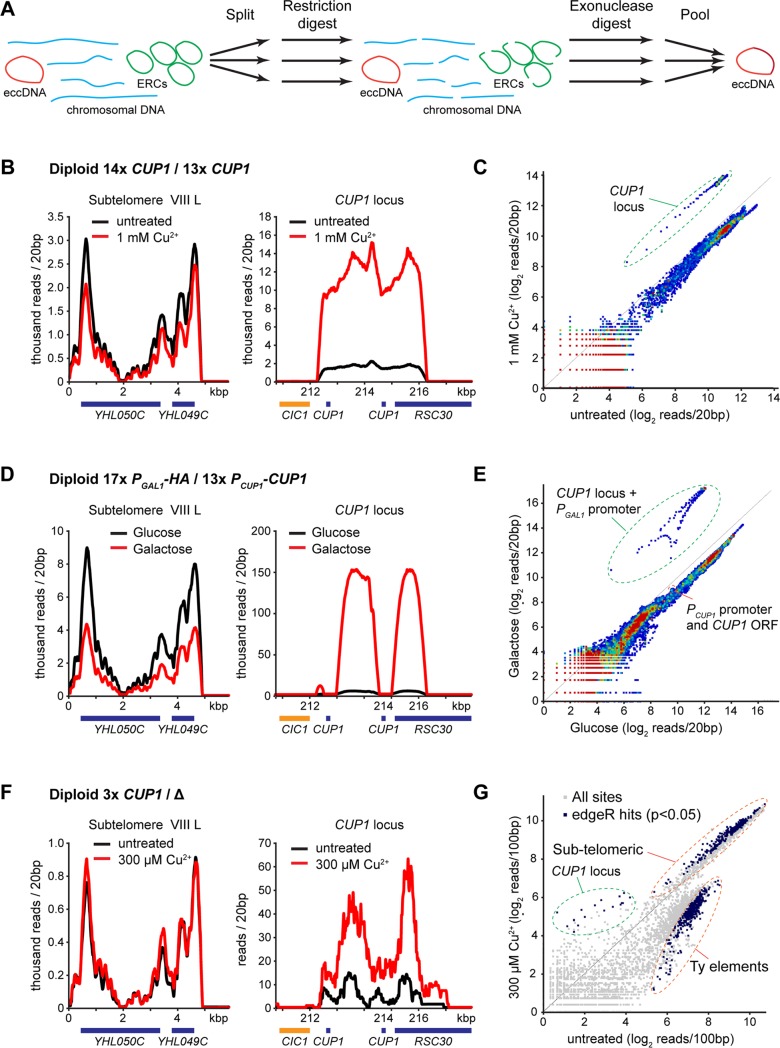
Genome-wide quantitative mapping of eccDNA in aged cells.(A) Schematic representation of library preparation method. Briefly, genomic DNA is split into 3 samples and digested with 3 different endonucleases that all target ERCs and 2μ DNA and then is digested with ExoV and ExoI. After 2 rounds of treatment, samples are reunited, fragmented, and a DNA sequencing library prepared by standard methods. (B) Distribution of sequencing reads around the CUP1 locus on Chromosome VIII and Subtelomere VIII L obtained from REC-seq of cells aged for 24 hours in the presence or absence of 1 mM CuSO4. (C) Scatter plot of read counts in 20 bp bins across the genome for samples shown in panel B. Circled points represent bins within the CUP1 repeat region. (D and E) Equivalent analysis to panels B and C performed on PGAL1-3HA/PCUP1-CUP1 heterozygous strain aged for 48 hours in glucose or galactose. The pronounced dip in reads mapping to the CUP1 locus over the actual CUP1 ORFs corresponds to the region of the CUP1 repeat replaced with PGAL1-3HA and demonstrates that essentially all the eccDNA is formed from the PGAL-3HA allele. Bins representing the CUP1 promoter and ORF are also highlighted in panel E. (F) Analysis of reads mapping to CUP1 locus and Subtelomere VIII L averaged across 3 biological replicates of 3xCUP1/Δ cells aged for 24 hours in the presence or absence of 300 μM CuSO4. (G) Scatter plot of average read counts across 3 biological replicates in 100 bp bins across the genome for samples shown in panel F. Blue dots are significantly different between cells aged in the presence or absence of copper based on edgeR analysis; p < 0.05. The genomic location of the different clusters of significantly different bins are indicated; all those within the CUP1 locus area are derived from CUP1 and are the most enriched in the presence of copper. The data underlying this figure may be found in S1 Data. eccDNA, extrachromosomal circular DNA; ERC, extrachromosomal ribosomal DNA circle; ExoV, exonuclease V; ORF, open reading frame; REC-seq, restriction-digested extrachromosomal circular DNA sequencing.